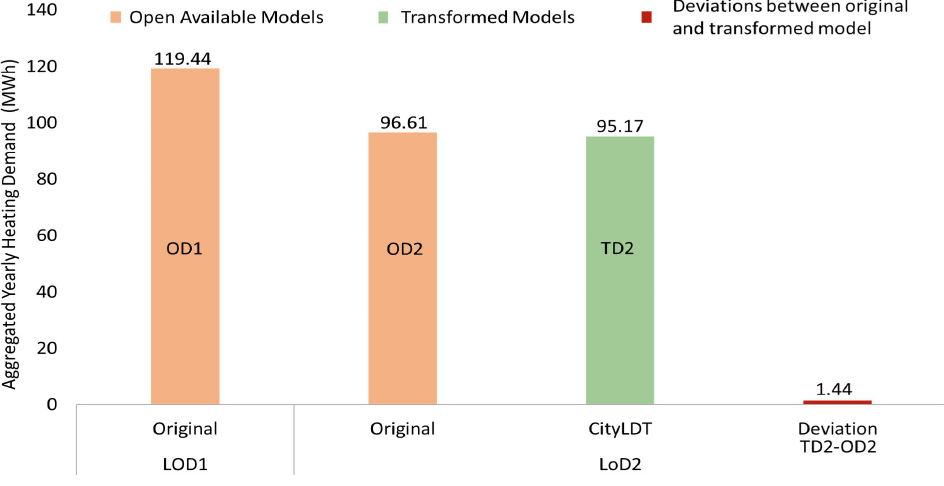
Figure 15. Comparison of heating demands (in MWh) for the open LoD1 (OD1), LoD2 (OD2) and the transformed CityLDT LoD2 (TD2) CityGML models over a period of one